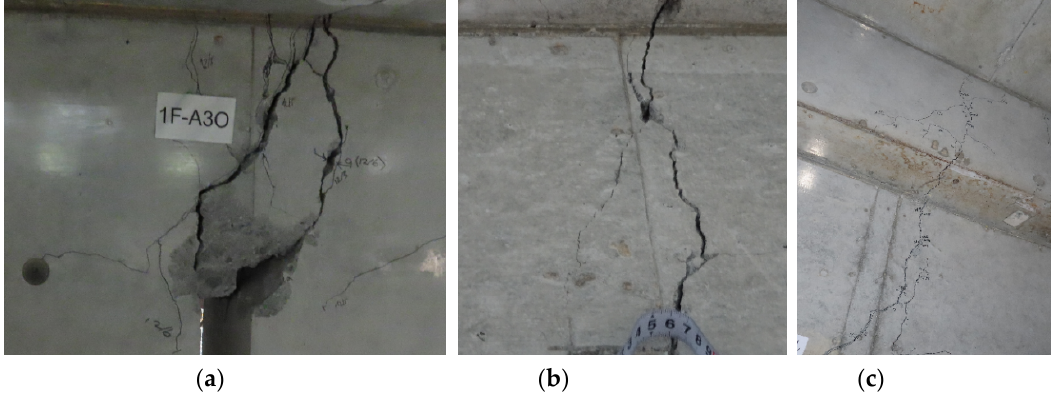
Figure 20. Damage at hanging walls under 150% of the designed waves: ( a ) first floor; ( b ) second floor; ( c ) third floor.